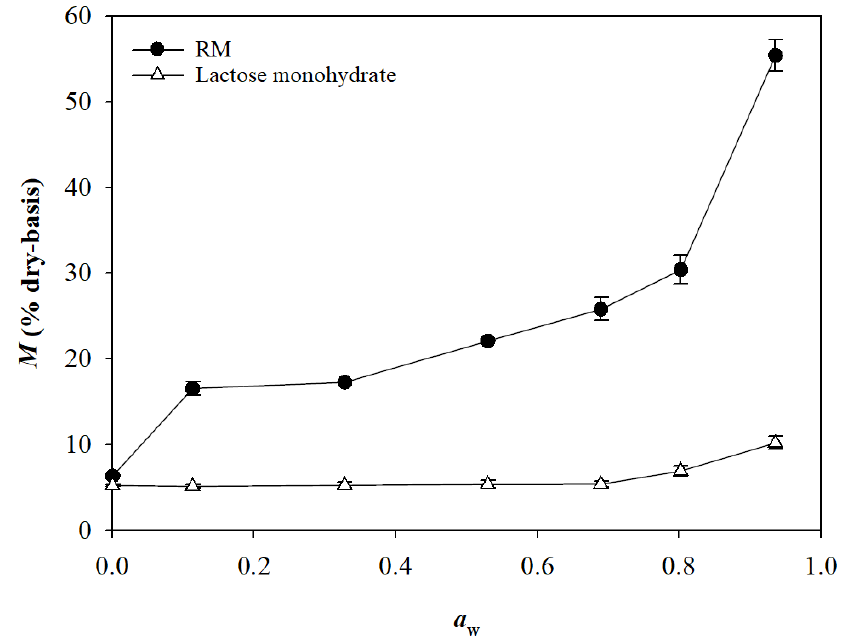
Figure 3. Moisture sorption isotherms of lactose monohydrate and resistant maltodextrin (RM) at 25 °C.